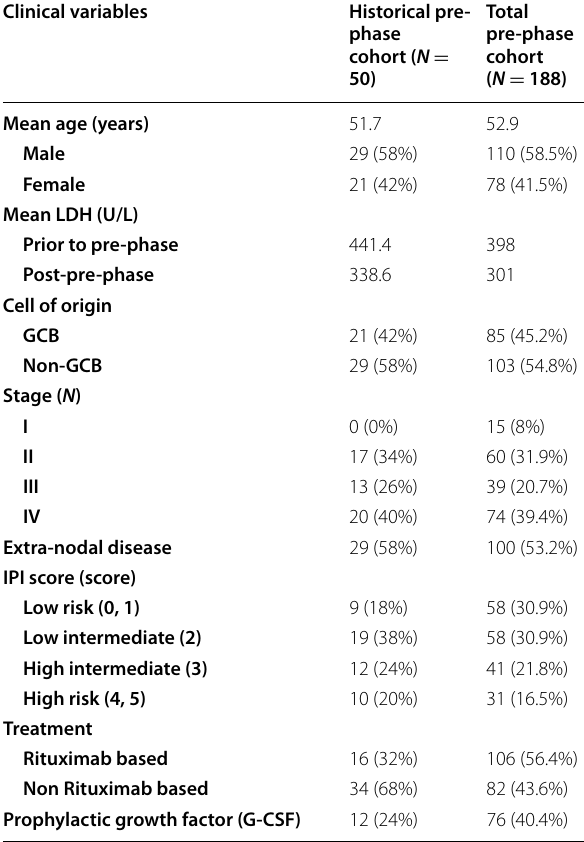
Table 1 Clinical profile of all patients receiving pre-phase therapy in comparison to the historical pre-phase